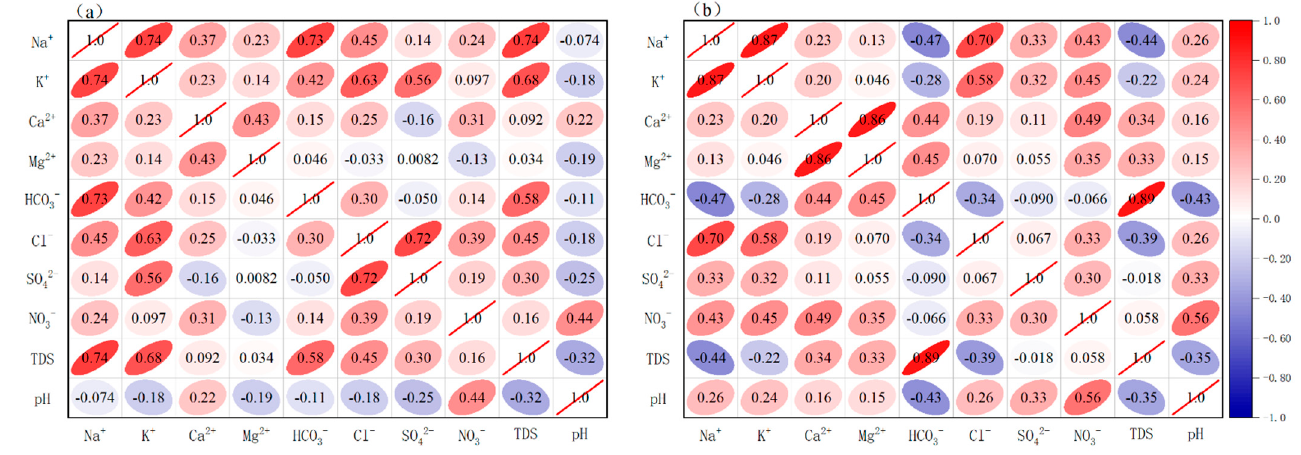
Figure 4. Ion correlation in the water samples: ( a ) river water ion correlations and ( b ) spring water ion correlations.